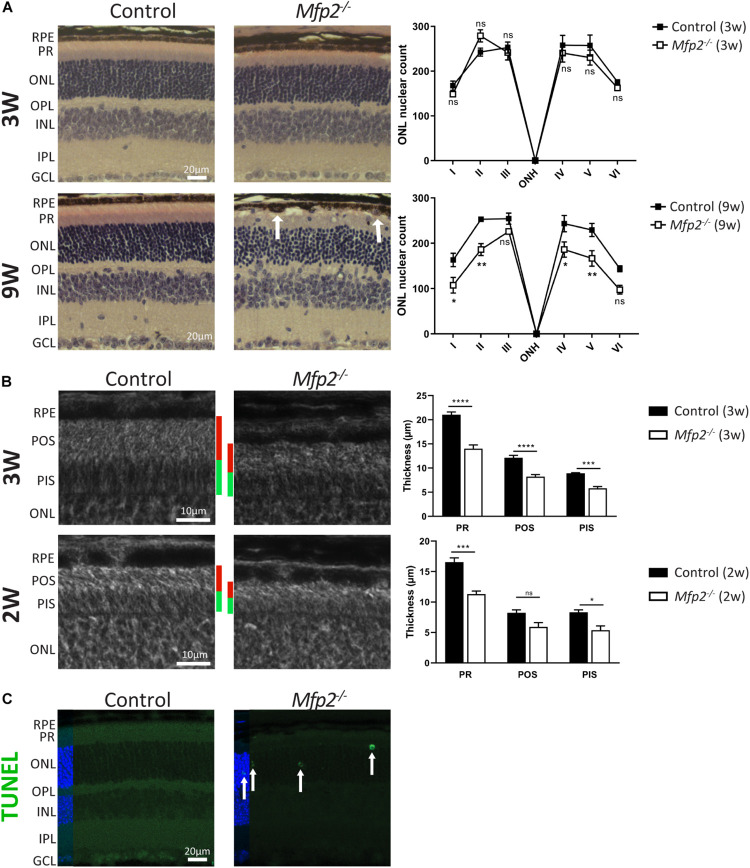
Morphological changes in Mfp2–/– retinas. (A) H&E staining reveals no gross morphological alterations, except for PR length reduction, in 3 weeks-old Mfp2–/– retinas and photoreceptor degeneration and protrusion of RPE cells in the POS layer (white arrows) in 9 weeks-old Mfp2–/– retinas. The spiderdiagrams show the quantification of the number of photoreceptor nuclei over a distance of 100 μm at six different positions: I, nasal-peripheral; II, nasal-middle; III, nasal-central; ONH, optic nerve head; IV, temporal-central; V, temporal-middle; VI, temporal-peripheral. (B) Phase-contrast microscopy of 3 and 2 weeks-old Mfp2–/– retinas show reduced photoreceptor outer (red bars) and inner segment (green bars) length. Mean ± SEM are shown (n = 3, 4 and 5 per genotype at 2, 3, and 9 weeks of age, respectively). Statistical significance was determined by two-way ANOVA with Bonferroni multiple comparisons test: ns p > 0.05, *p < 0.05, **p < 0.01, ***p < 0.001, ****p < 0.0001. (C) Increase in TUNEL-positive nuclei (white arrows) reveals an increase in apoptotic cell death of photoreceptors in 3 weeks-old Mfp2–/– mice (n = 3 per genotype). Hoechst (blue) was used as nuclear counter stain. RPE, retinal pigment epithelium; PR, photoreceptor layer; POS, photoreceptor outer segment; PIS, photoreceptor inner segment; ONL, outer nuclear layer; OPL, outer plexiform layer; INL, inner nuclear layer; IPL, inner plexiform layer; GCL, ganglion cell layer.